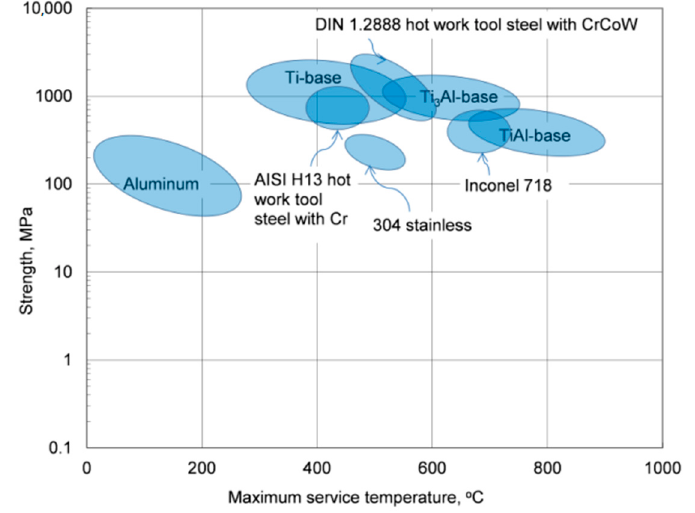
Figure 1. Strength versus maximum service temperature for aluminum alloys and selected structural materials.